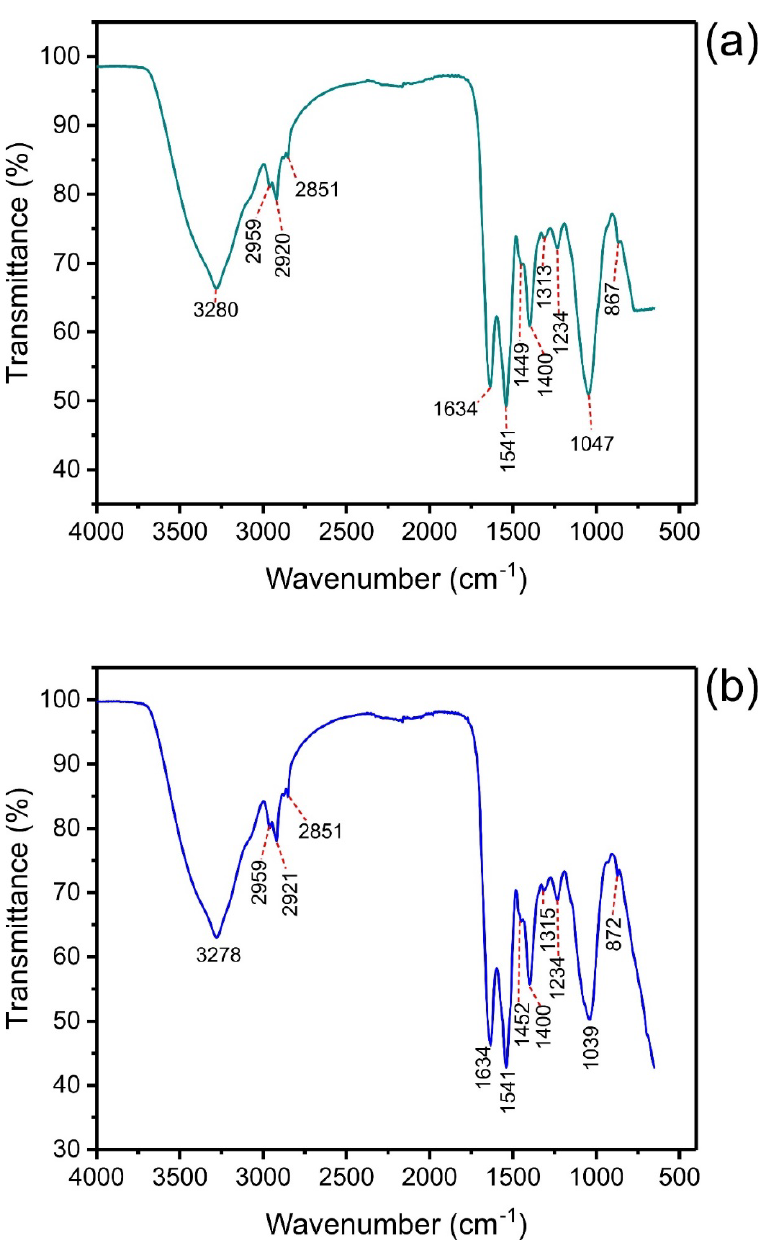
Figure 2. FTIR of ( a ) LEB − 18 S. platensis ; ( b ) LEB − 52 S. platensis . The FTIR bands of these two strains are practically the same. The band at 3280 cm − 1 (LEB-18) and 3278 cm − 1 (LEB-52) are assigned to the stretching of O-H groups [42,43]. The bands at 2959 and 2920 cm − 1 (LEB18) or 2921 cm − 1 (LEB-52) are assigned to asymmet- ric C-H stretching. In addition, the band at 2851 cm − 1 is attributed to symmetric C-H stretching [42,43]. The band at 1634 cm − 1 could be assigned to C=O present in lipids of S. platensis [42,43]. The strong band at 1541 cm − 1 is assigned to the N-H bending of